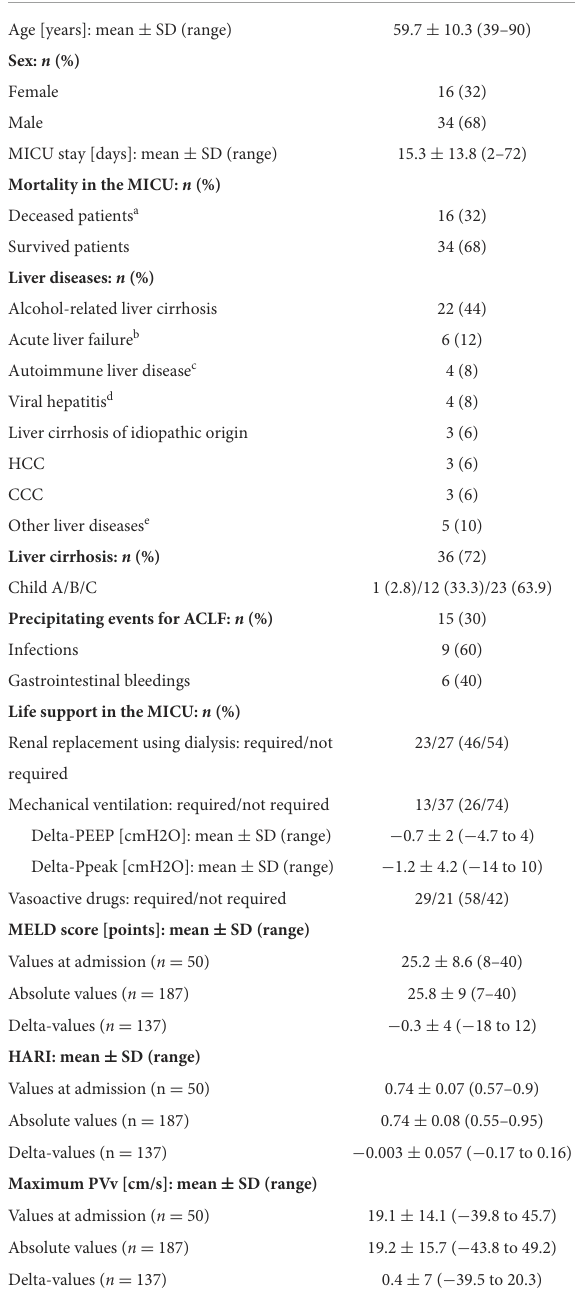
TABLE 1 Clinical characteristics of the study cohort.